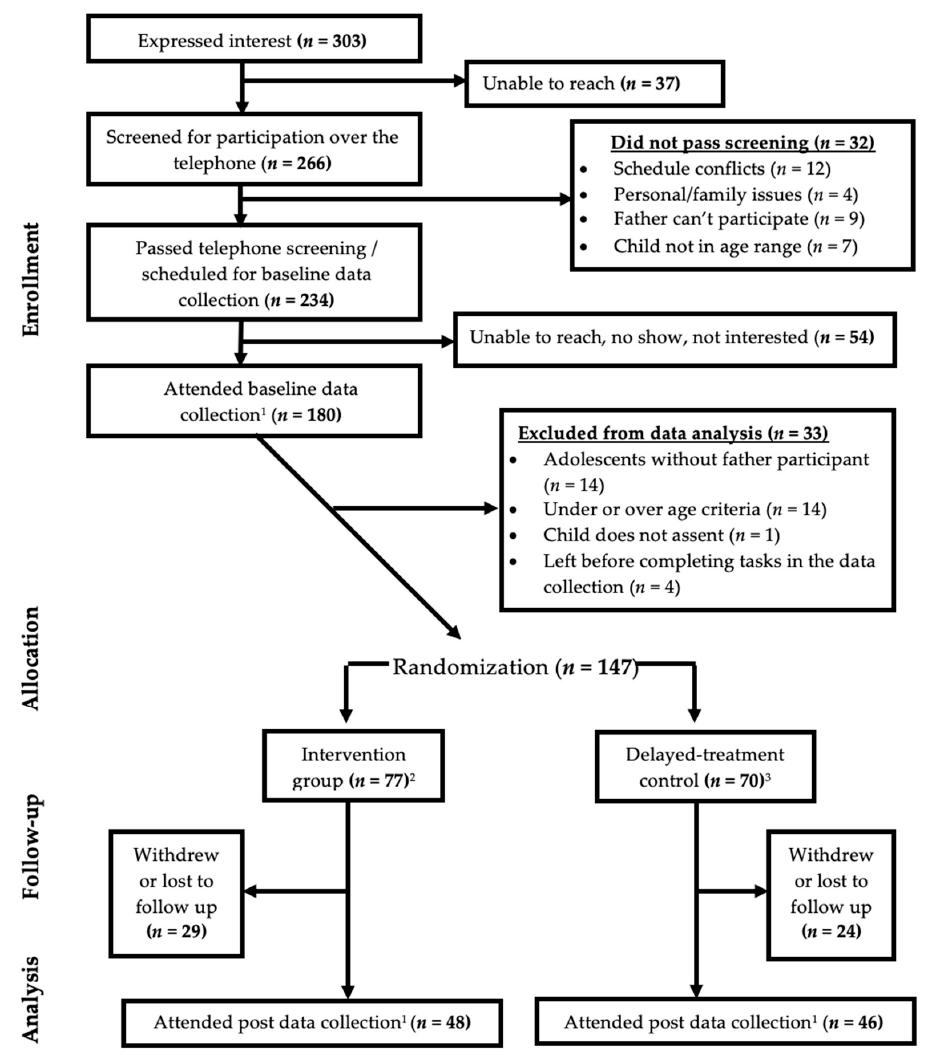
Figure 1. CONSORT diagram (Father/adolescent dyads) [29]. 1 Participants reported frequency of paternal parenting practices; 2 Four participant dyads were randomized to intervention but attended delayed-treatment control group educational sessions; 3 Seven participant dyads were randomized to delayed-treatment control but attended intervention group sessions.